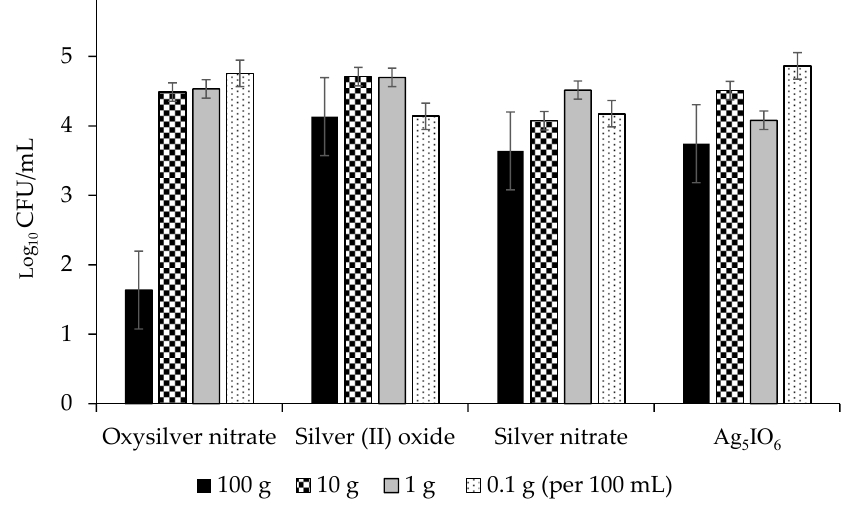
Figure 7. Effects of four silver-based seed coatings on the lg growth (CFU/mL) of Curtobacterium flaccumfaciens pv. flaccumfaciens .